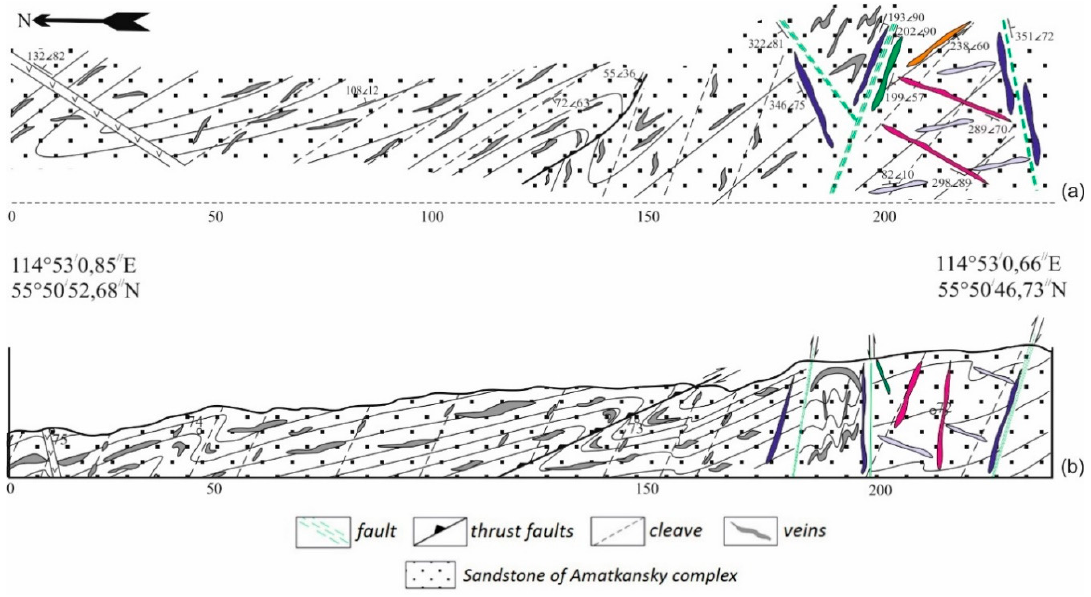
Figure 3. The structure of the quartz veins of the Beregovoy zone: ( a ) Plan view; and ( b ) N–S profile. The blue color indicates the main veins, pink, orange and lilac color indicates syndeformational veins, and green color indicates submain veins.